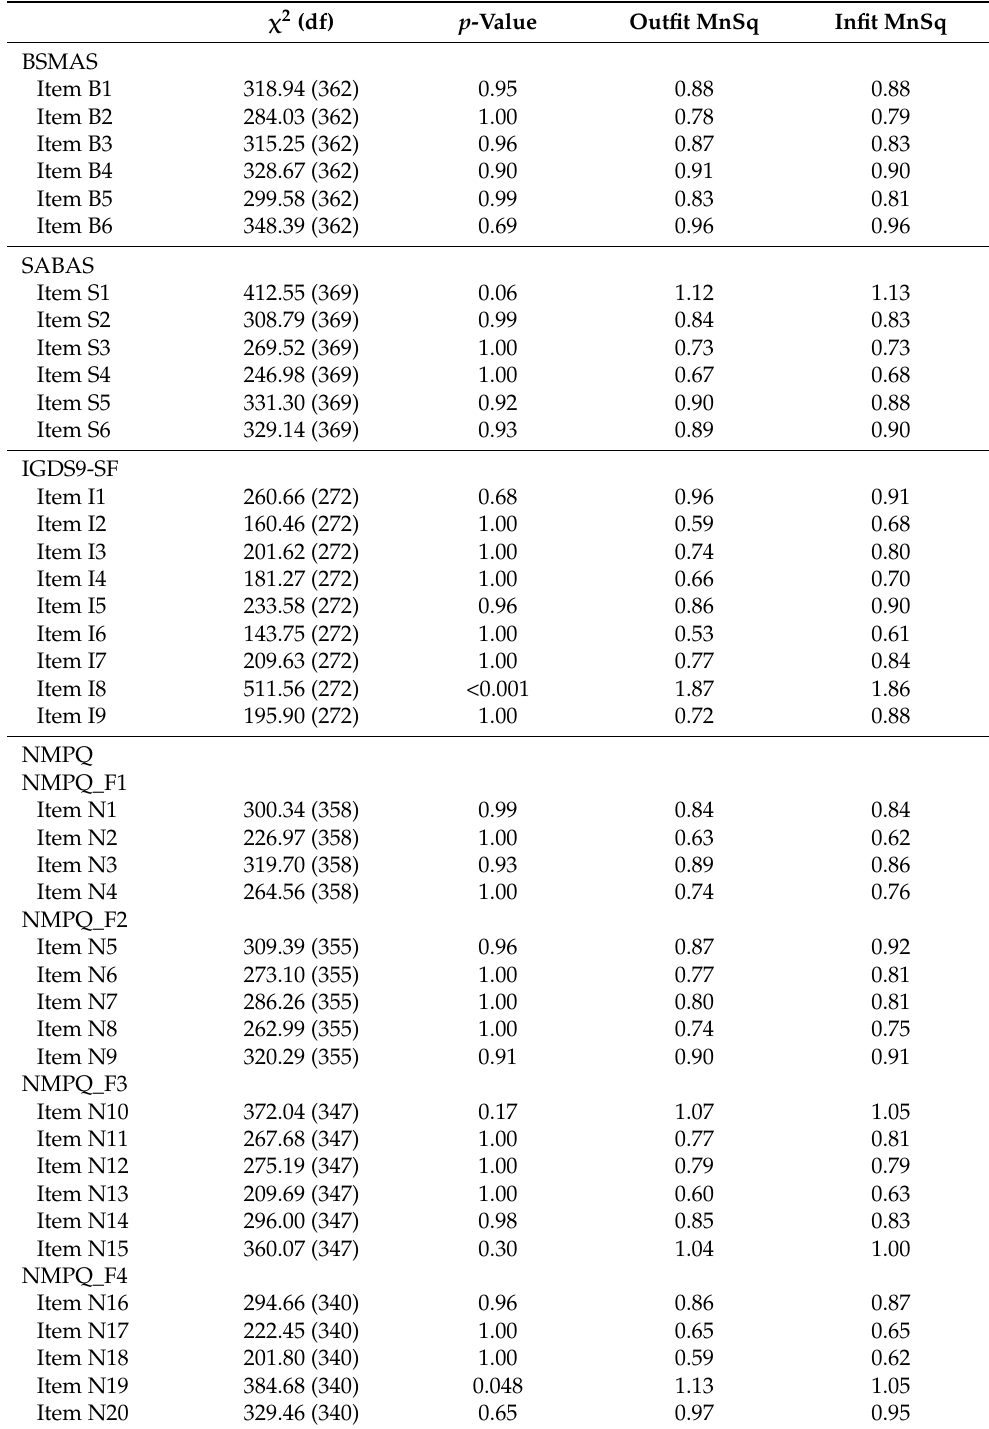
Table 4. Psychometric results derived from Rasch analysis on the internet-related